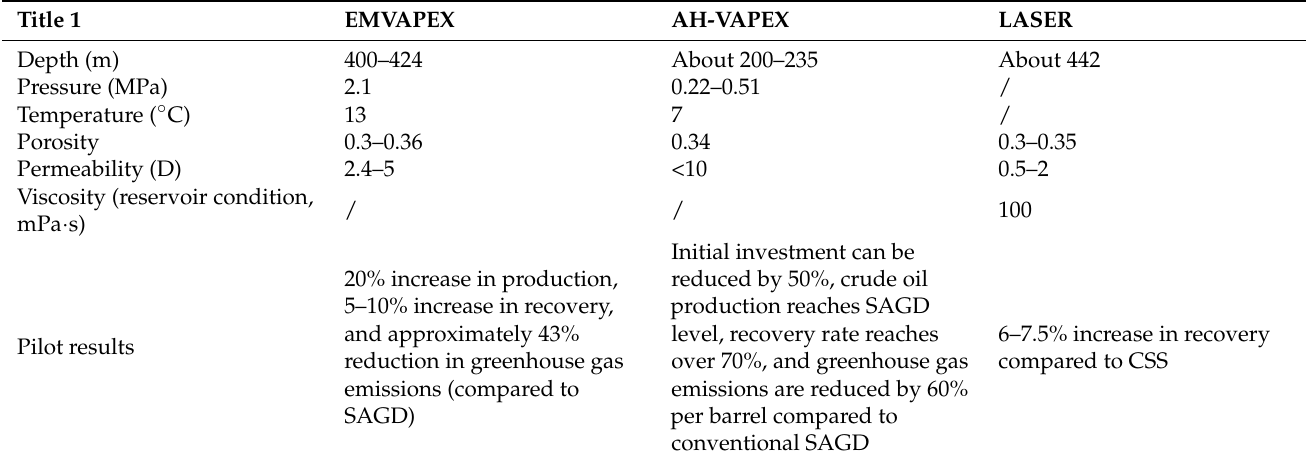
Table 2. Comparison of project pilot reservoir